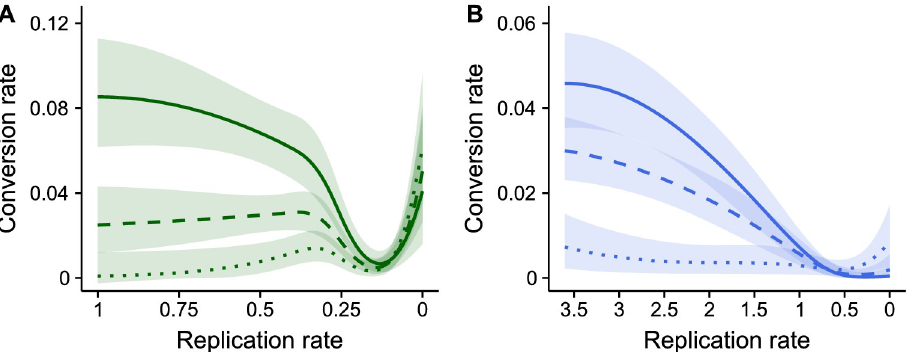
Fig 5. In addition to state, changes in red blood cell (RBC) density modulate conversion rates. The reproductive restraint region of reaction norms for ( A ) ER and ( B ) CWvir are steeper when RBC density is increasing (solid lines; 90 th percentile) compared to remaining constant (dashed lines; 50 th percentile) or decreasing (dotted lines; 10 th percentile). Percentiles for RBC change are used to normalise for the differing dynamics between the experiments and are calculated as the difference in RBC density between the decision-making and parental cohorts of asexuals. Solid lines and shaded areas are predictions ± SEM from generalised additive models for conversion as a function of both replication rate (state) and changes in RBC